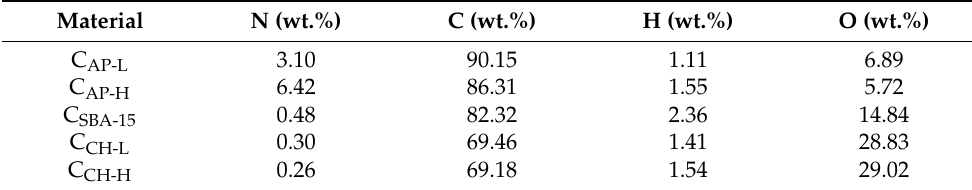
Table 1. The elemental composition of carbon carriers.